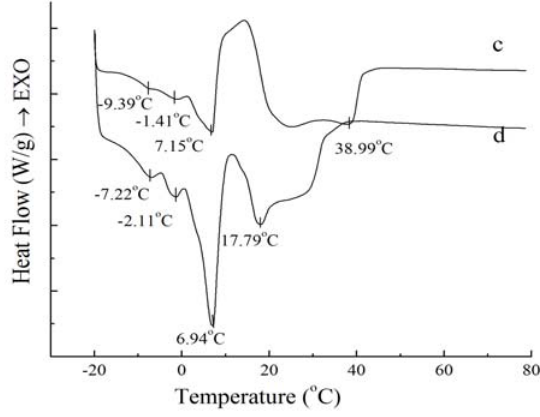
Figure 2. Melting curves of PS ( c ) and PO ( d